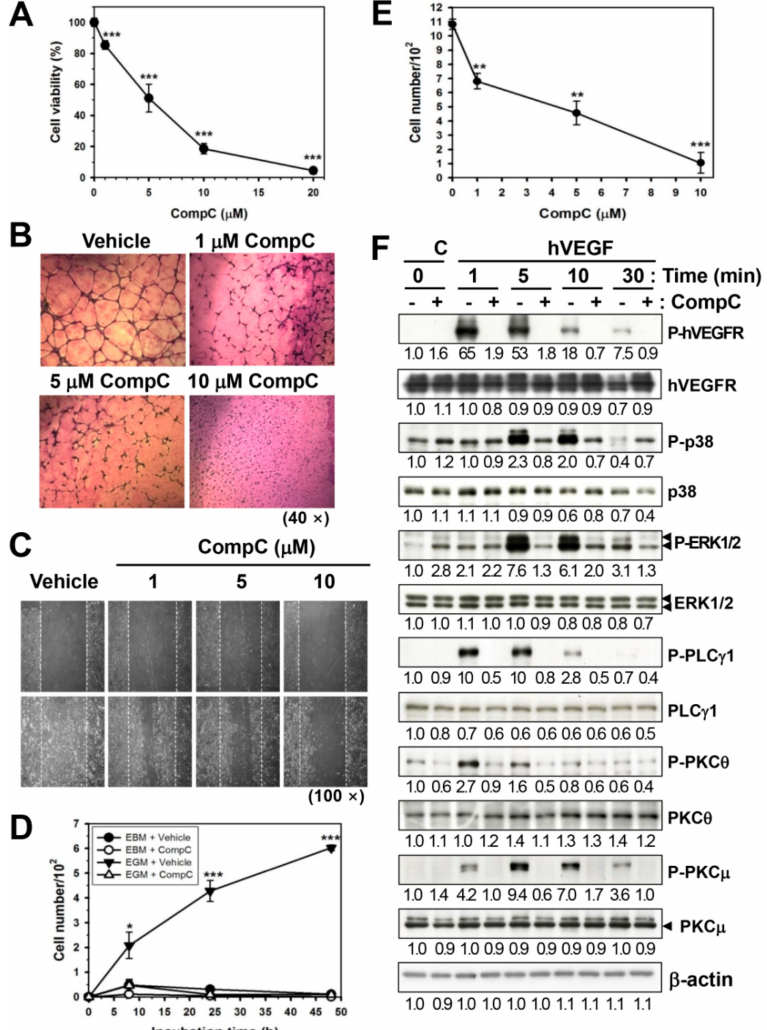
Figure 4. CompC reduced cell viability, tube formation, cell migration, and vascular endothelial growth factors (VEGF)-induced signal transduction in human umbilical vein endothelial cells (HUVECs). ( A ) HUVECs were treated with CompC (1–20 µ M), an MTT assay was performed, and the percentage of cell viability is plotted in ( A ). ( B ) The HUVEC suspension was added to Matrigel-coated wells on a 24-well plate. CompC (1–10 µ M) was added to endothelial growth media kit 2 (EGM-2) and incubated for 18 h. The cells were stained with Di ff -Quik and photographed (40 × ). ( C – E ) HUVECs were grown to 70–80% confluence in a 6-cm culture dish in EGM-2 medium, and some areas were denuded. Cells were then incubated in the culture medium containing various concentrations of CompC and photographed in ( C ) (100 × ). The number of HUVECs that migrated to the acellular area was counted and plotted in ( D ) (time-dependency) and ( E ) (dose-dependency). ( F ) HUVECs were serum-starved by incubation with endothelial cell basal medium (EBM) for 24 h. Cells were treated with EBM containing 50 ng / mL human VEGF (hVEGF) for the indicated times in the presence of vehicle ( − ) or 10 µ M CompC ( + ). Cell lysates were analyzed by western blotting with antibodies against total and phosphorylated hVEGF receptor (hVEGFR) and other signaling proteins. * p < 0.05, ** p < 0.01, and *** p < 0.001,